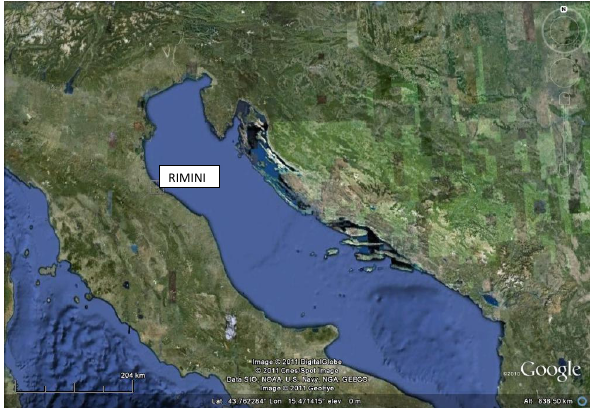
Fig. 1. Study site location.